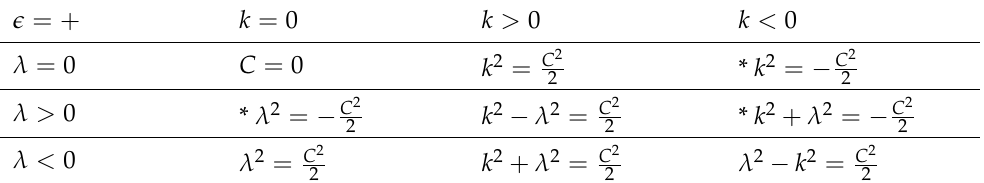
Table 1. Possible relations between the constants of integration in the canonical sector, (cid:101) = + 1. The ∗ indicates the cases that give complex values for the constants, which are not of interest.